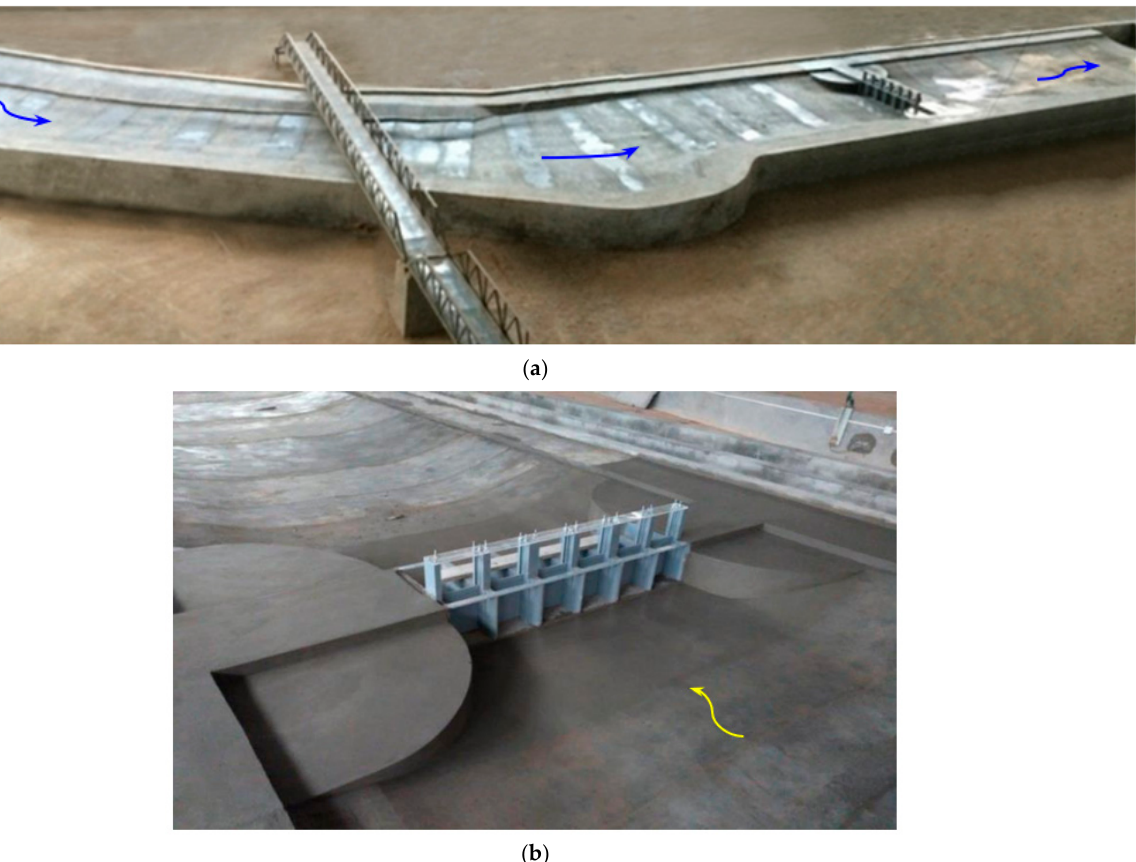
Figure 7 . Laboratory model of the sluice with six bulkhead gates constructed in scale λ = 1:40, with a 30 m length measured along the river centerline and a 4 m width in cross-section. ( a ) View from the right bank; ( b ) sluice structure, looking downstream.